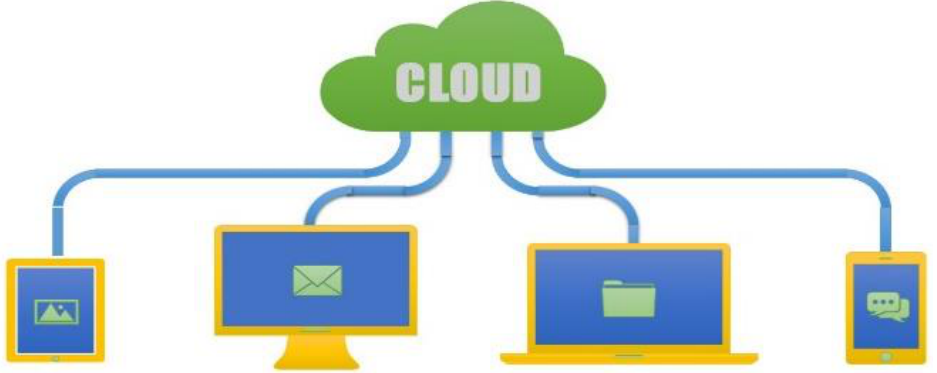
Figure 1. Cloud based computing and communication.